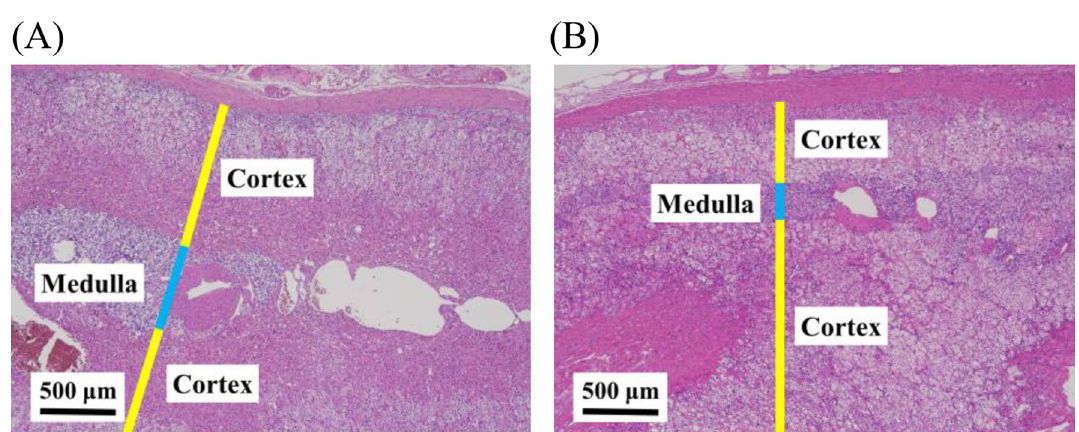
Figure 3. Adrenal parenchyma behind typical functional adenocortical adenomas. ( A ) Adrenal parenchyma behind a typical cortisol-producing adenoma ( B ) Adrenal parenchyma behind a typical aldosterone-producing